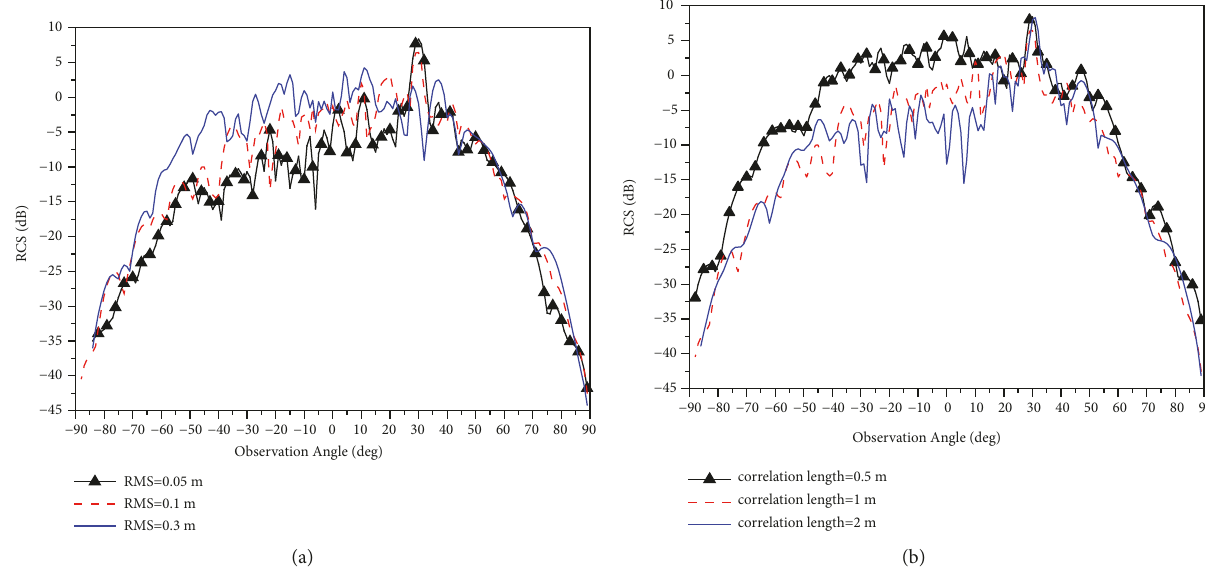
Figure 12: Relationship between the ground roughness and RCS. (a) RCS with different RMS of ground surface. (b) RCS with different correlation length of ground